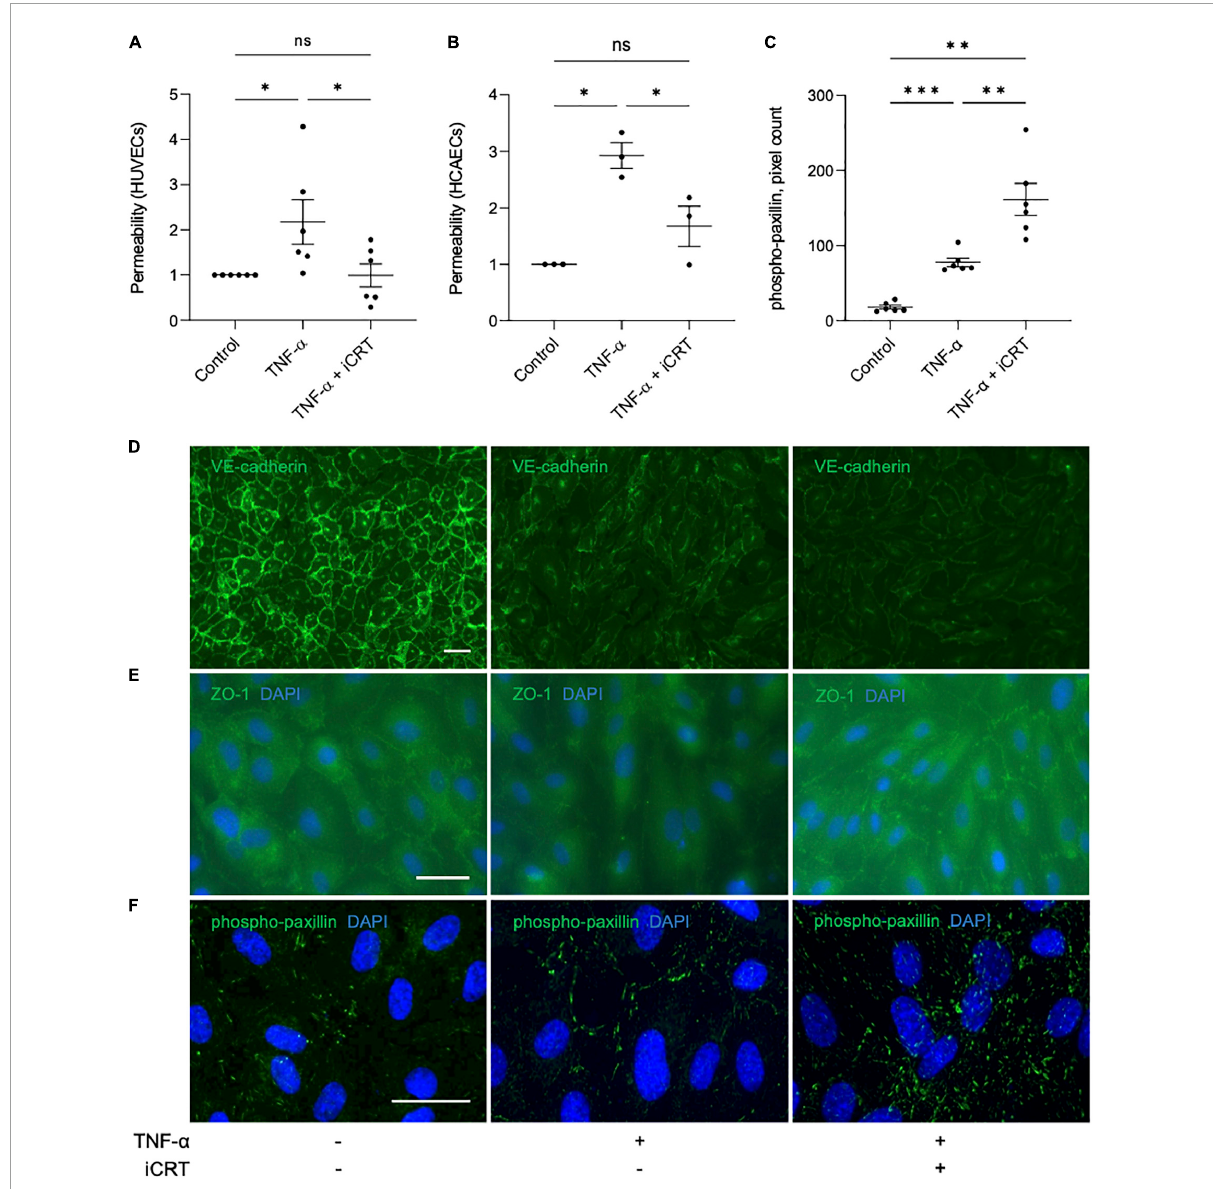
FIGURE4 Inhibition of Wnt/ β -catenin signaling restored barrier function in TNF- α -stimulated endothelial cells. Cultured endothelial cells were stimulated with 10 ng/mL recombinant human TNF- α in the presence of either 0.05% DMSO vehicle control or 25 µ M inhibitor of β -catenin-responsive transcription (iCRT) for 18 h. Human umbilical vein endothelial cells (HUVECs) (A) or HCAECs (B) were seeded in Transwell inserts and streptavidin-HRP leakage across the endothelial monolayers was quantified. Data are expressed as a fold change of control ( n = 6 and 3, respectively) (C) . In HUVECs, following immunofluorescence for phospho-paxillin (Tyr118), total phospho-paxillin (Tyr118) levels were quantified using a Fiji-based macro, and normalized to cell count ( n = 6). Representative images of HUVECs immunostained (green) for VE-cadherin (D)